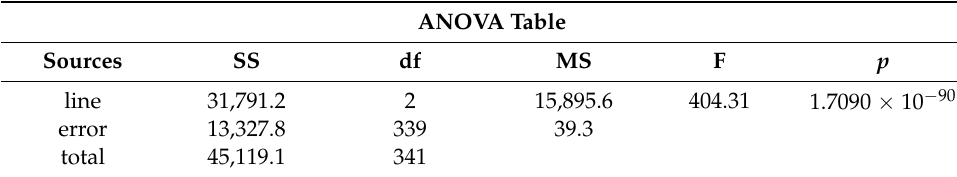
Table 4. The grading index corresponds to the symbol description.